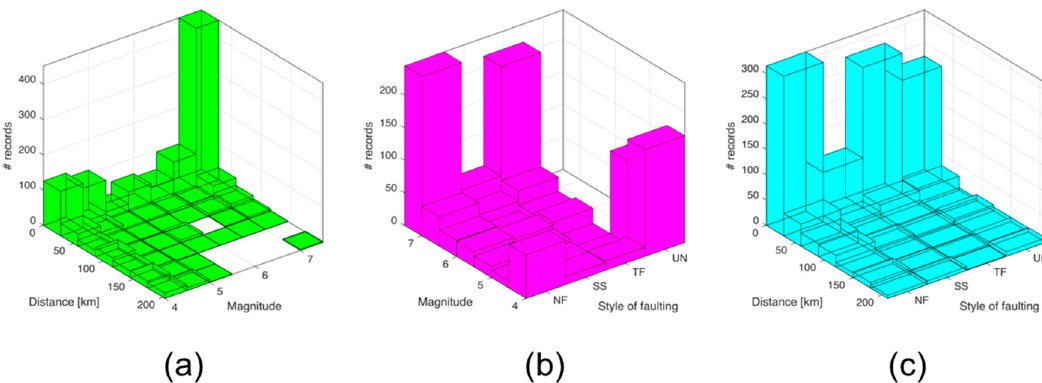
Figure 18. Histograms of a generic dataset (SET1) of the hybrid GMPE calibrations, for magnitude versus distance ( a ); magnitude versus style of faulting ( b ); and distance versus style of faulting ( c ). NF, normal faulting; SS, strike-slip; TF, reverse faulting; UN, undefined faulting. SET1 is still not completely balanced, as some distance–magnitude ranges are not covered